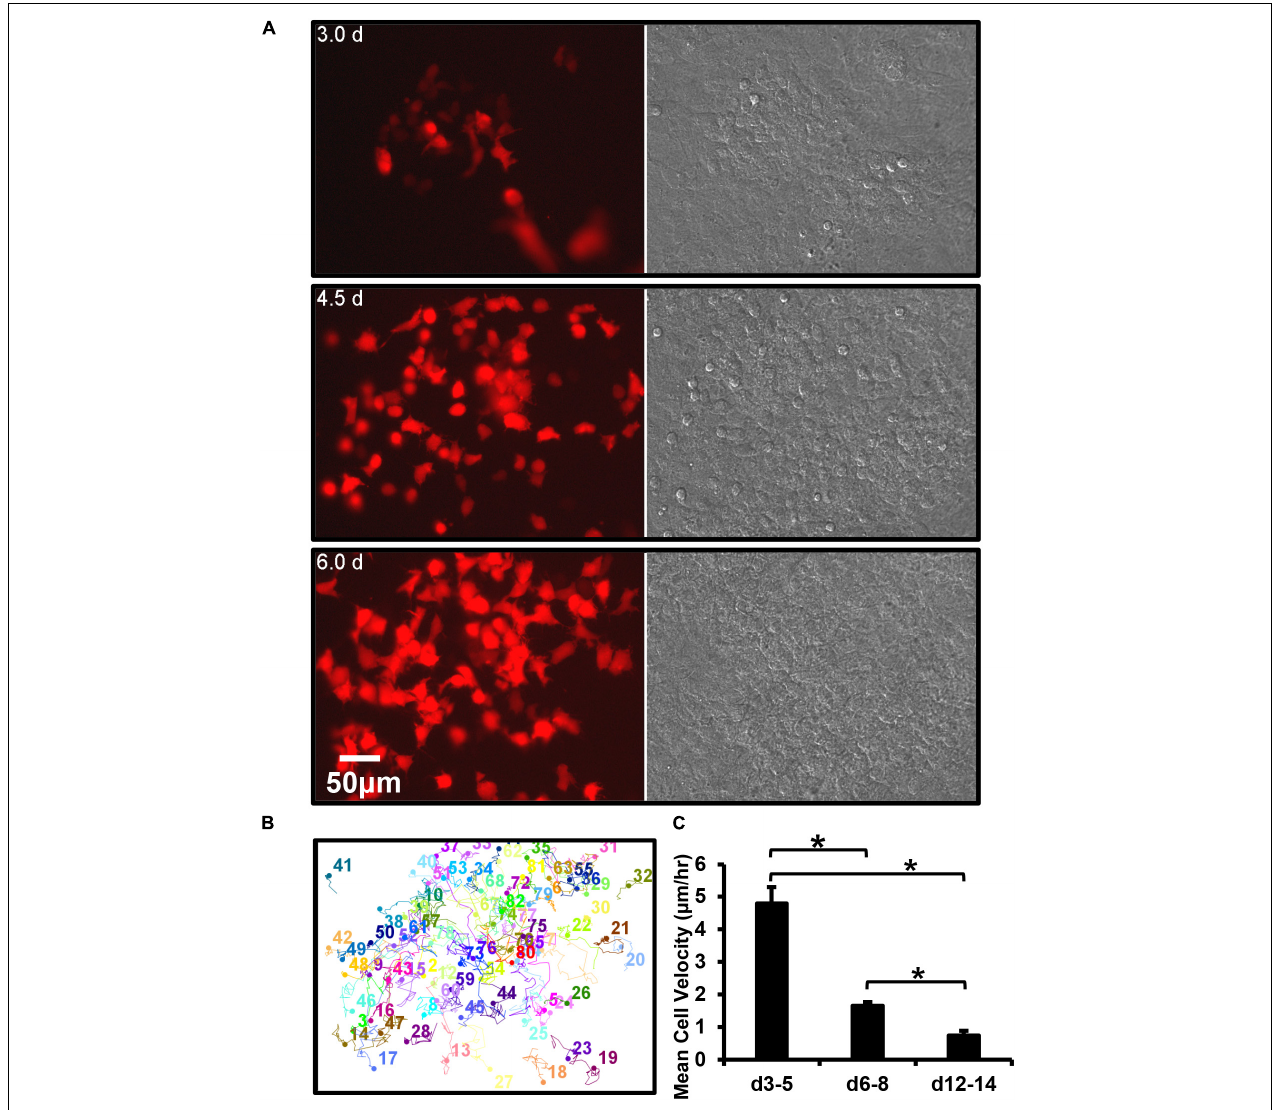
FIGURE 5 | Dmp1-Cre/tdTomato reporter switches on in a post-mitotic cell that is initially motile and then embeds. (A) Still frames from a timelapse movie showing the dramatic increase in tdTomato-positive cells over time in osteogenic calvarial cell cultures from Dmp1-Cre/tdTomato transgenic mice, bar = 50 µ m. The tdTomato-positive cells arise exclusively from new cells switching on tdTomato rather than from mitotic division of cells already expressing tdTomato, which is best appreciated by viewing Supplementary Movie 10 . (B) Motion trajectory plots for individual cells within the movie field. (C) Graph showing the average velocities of tdTomato-positive cells over 3–5, 6–8, and 12–14 days. Data are mean ± SEM from n = 9 independent movies for d3–5 and n = 10 for d6–8 and d12–14. ∗ p < 0.05 (ANOVA/Student Newman